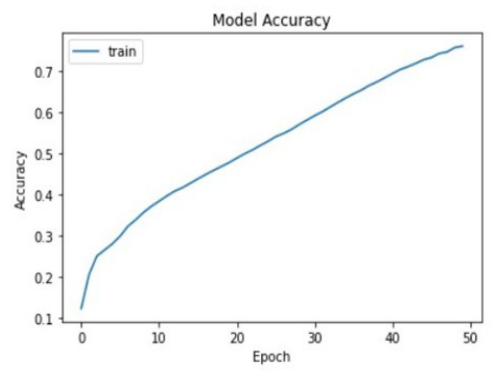
Fig. 7. Epoch vs Accuracy Graph